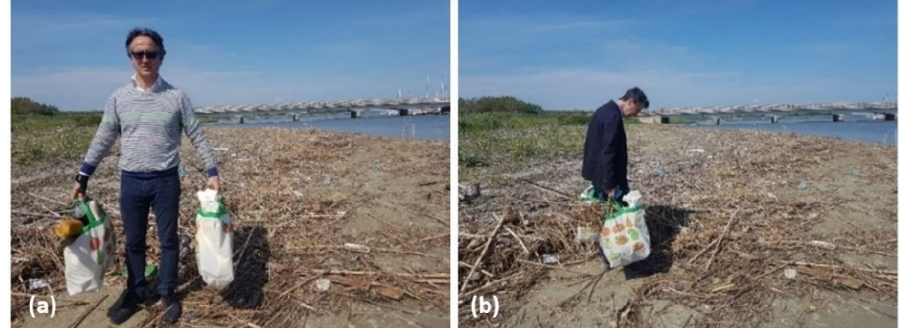
Figure 3. CNR ( a ) and ISPRA ( b ) researchers engaged in the collection of the waste.